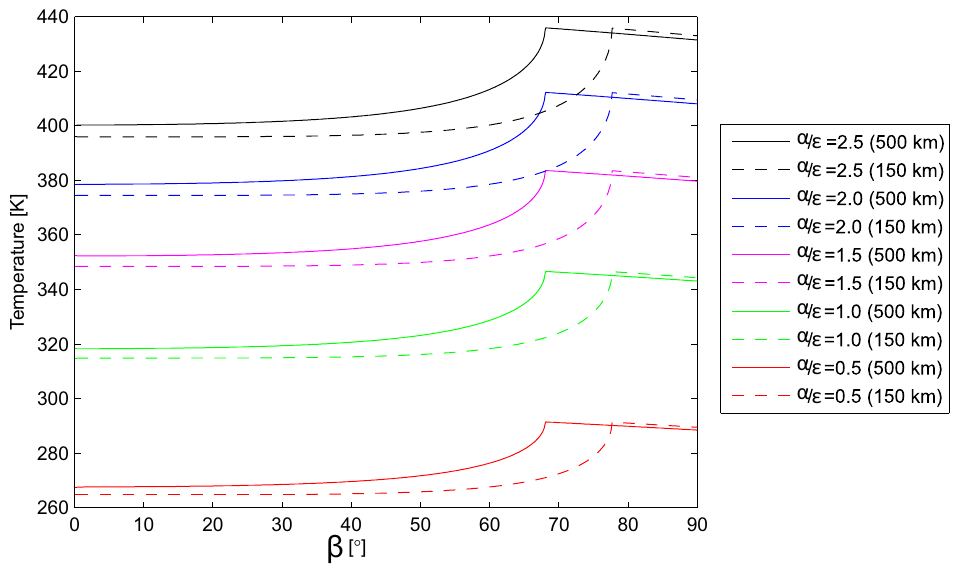
Figure 7. Average temperature as function of ratio α / (cid:101) and β . The solid lines (—) are valid for the altitude of 500 km and the dashed lines (- -) are for altitude of 150